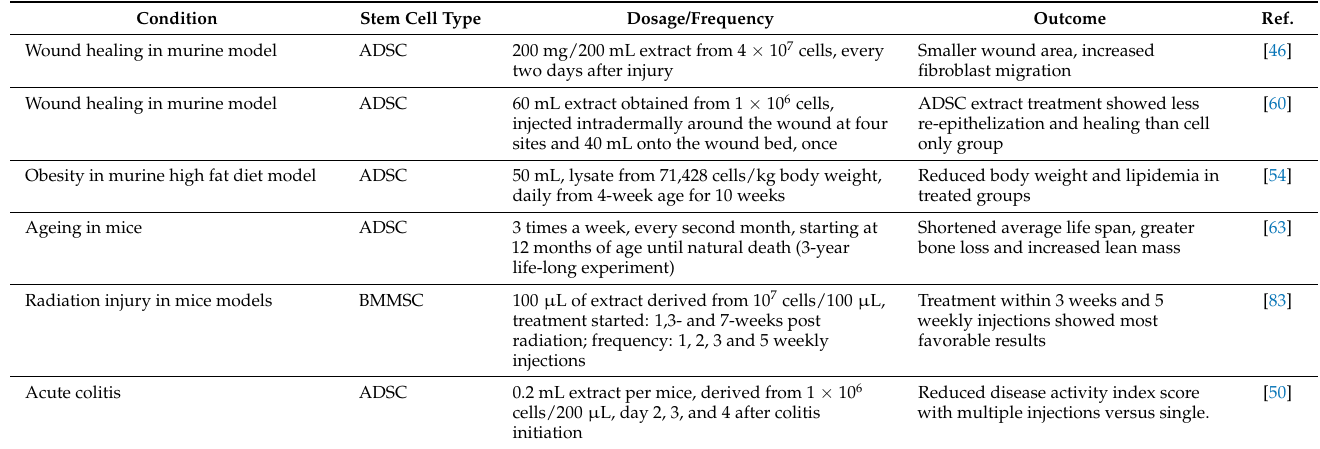
Table 2. Effects of dosage and frequency of cell